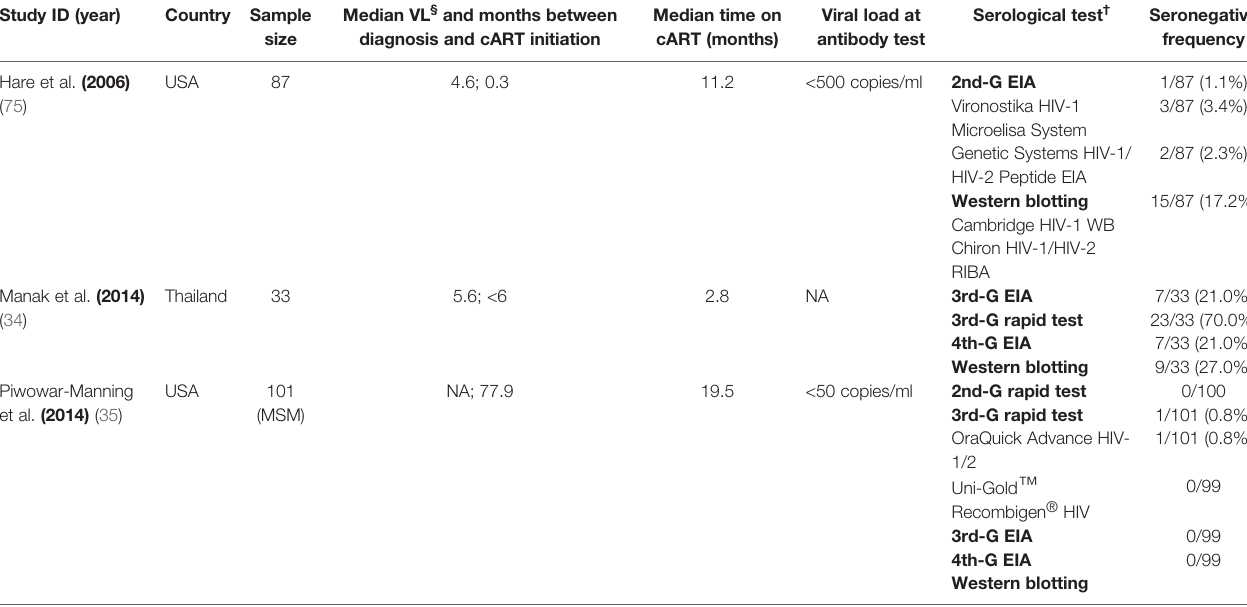
TABLE 2 | Estimated frequency of HIV-1 seronegativity in cART-treated adult